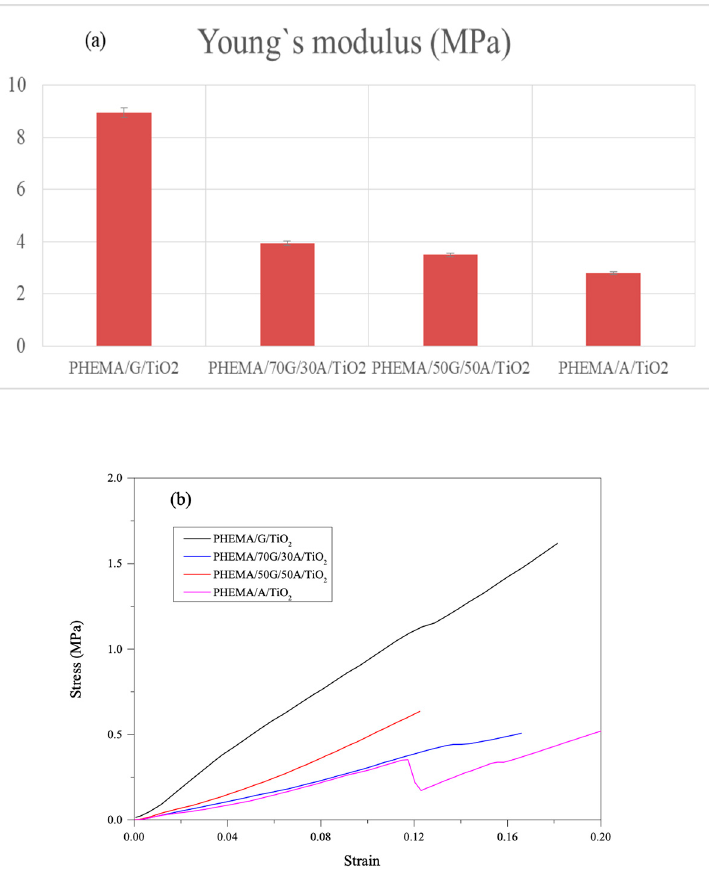
Figure 6. ( a ) Modulus values of PHEMA/G/TiO 2, PHEMA/70G/30A/TiO 2 , PHEMA/50G/50A/TiO 2, PHEMA/A/TiO 2 hybrids; ( b ) Stress-strain curves of PHEMA/G/TiO 2, PHEMA/70G/30A/TiO 2 , PHEMA/50G/50A/TiO 2, PHEMA/A/TiO 2 hybrids.